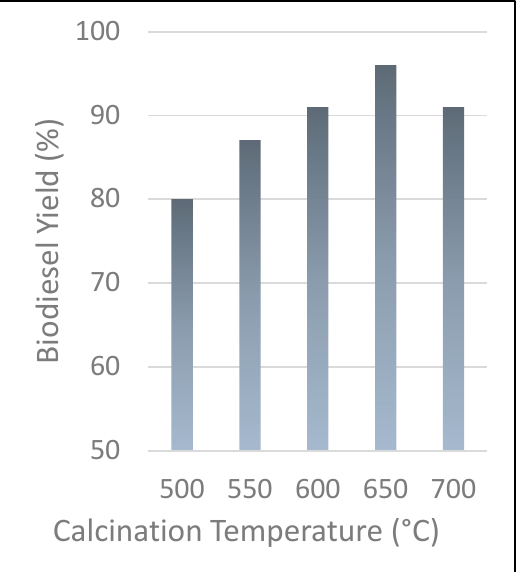
Figure 9. Comp Name: 9-Hexadecanoic acid, methyl ester, Run Time: 15.167, Mol Weight: 268. Figure 10. Comp Name: Hexadecanoic acid, methyl ester, Run Time: 15.402, Mol Weight: 270. Figure 11. Comp Name: 9-Octadecanoic acid (Z)-, methyl ester, Run Time: 17.386, Mol Weight: 296. Figure 12. Comp Name: Methyl stearate, Run Time: 17.664, Mol Weight: 298.